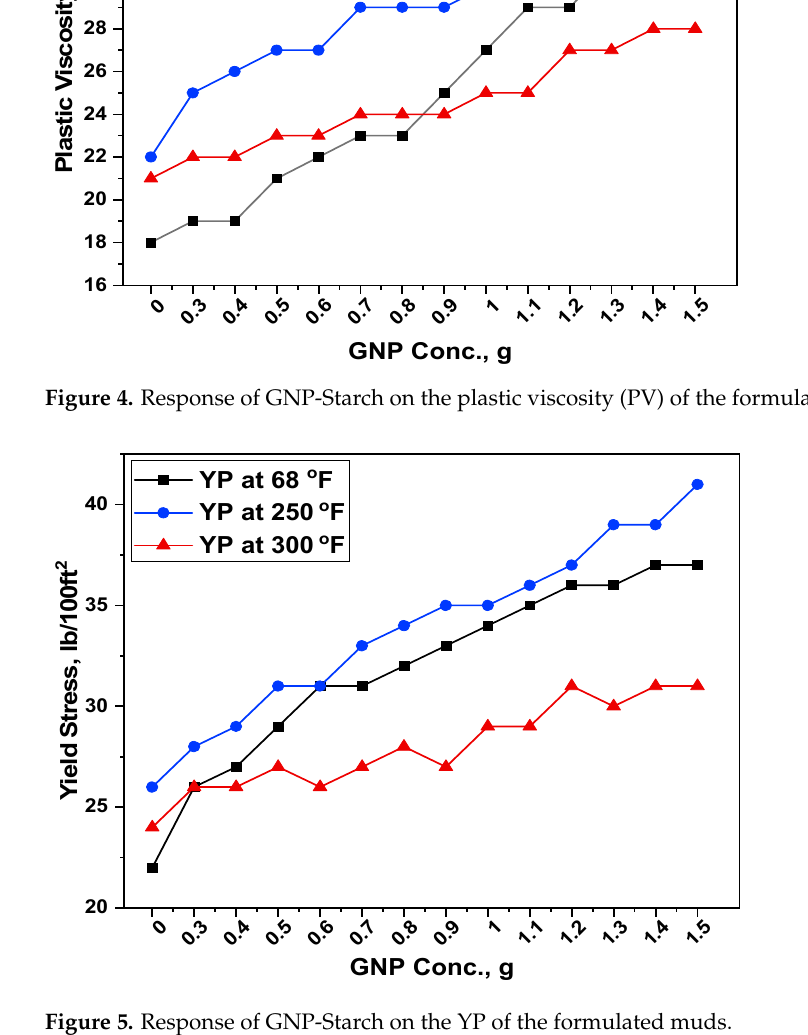
Figure 5. Response of GNP-Starch on the YP of the formulated